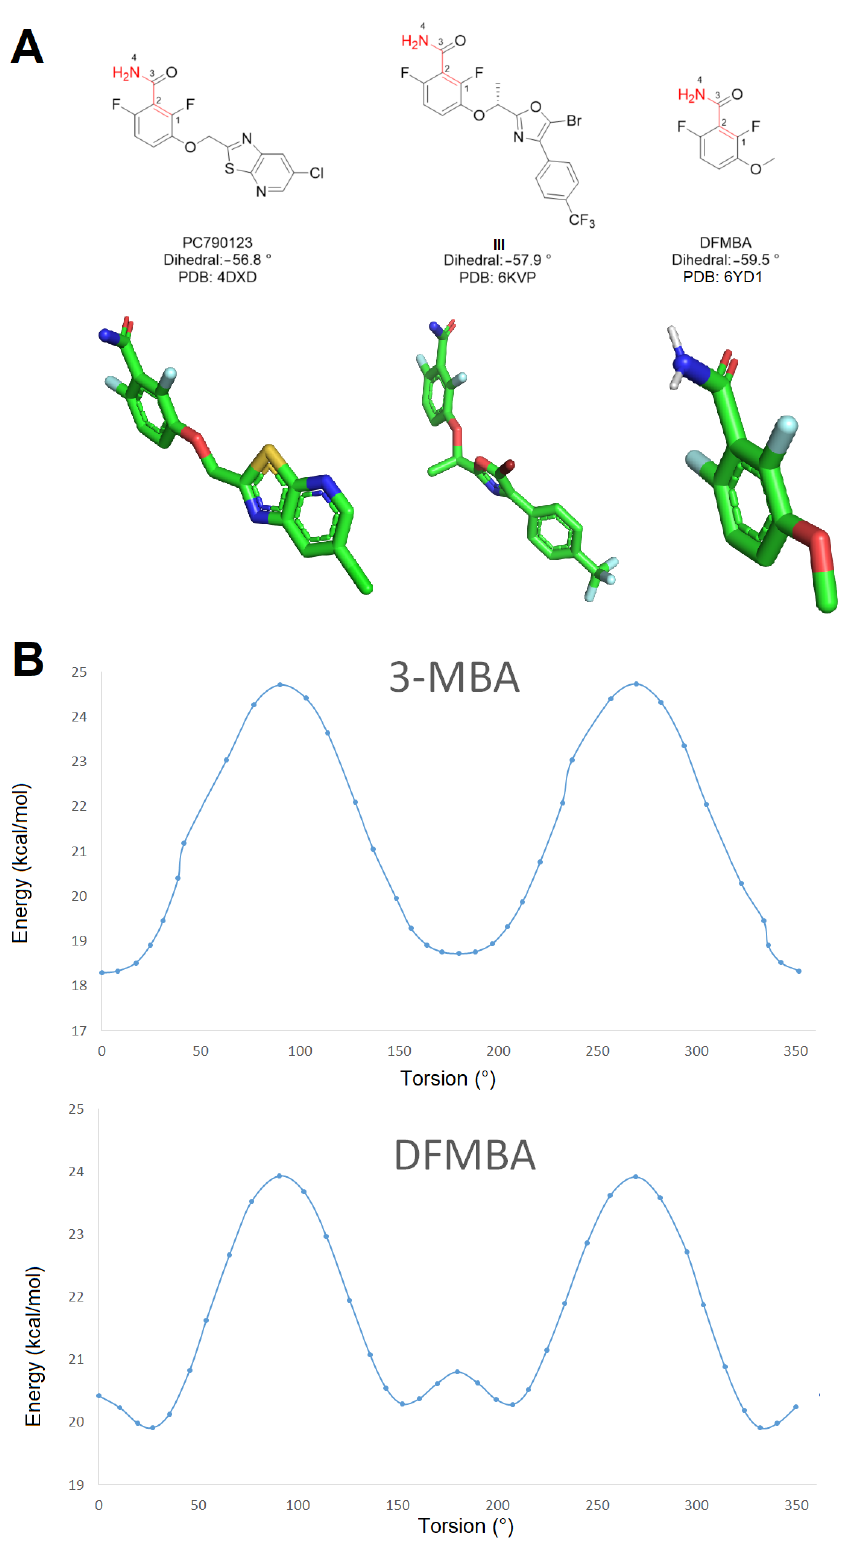
Figure 3. ( A ) Conformations of PC190723 [26] and other 2,6-difluorobenzamide derivatives (DFMBA and compound III ) [11,28] co-crystallized with FtsZ. ( B ) Conformational analysis of the 3-MBA and DFMBA resulting from a systematic conformational search by varying the torsion defined by the rotation around the bond between the amide functional group and the aromatic ring (increment of 10 ◦ and subsequent